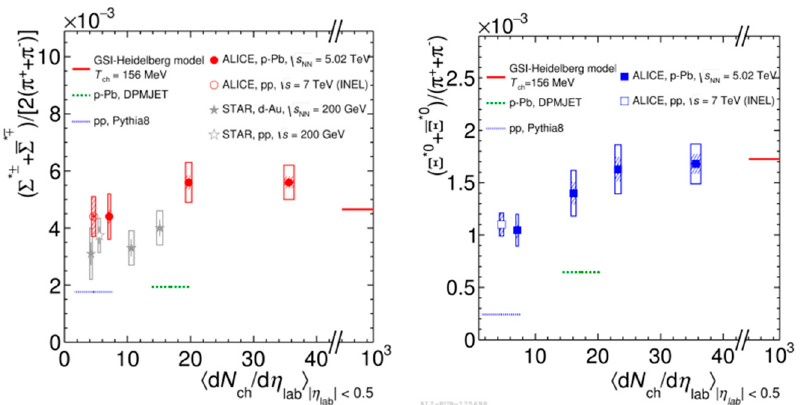
Figure 3. Ratio of Σ (1385) ± to π ± ( left ) and Ξ (1530) 0 to π ± ( right ) measured in pp, d-Au and p-Pb collisions as a function of the mean charged-particle multiplicity density. Statistical (bars) and systematic uncertainties (boxes) are shown. The shaded boxes are the multiplicity. Model predictions are also presented as lines at the appropriate abscissa. Figure taken from [2].